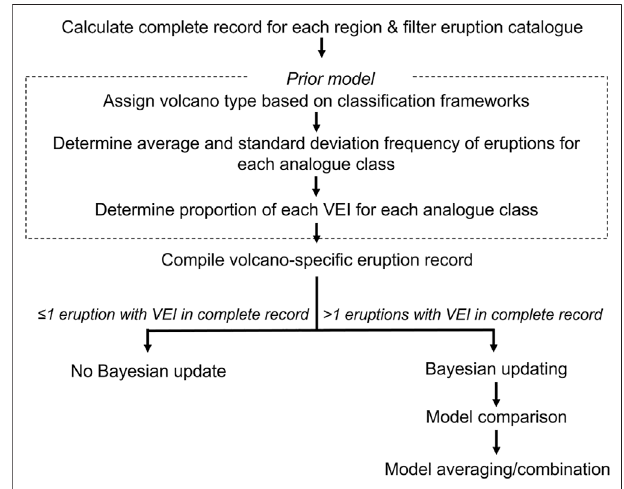
FIGURE 1 | Conceptual overview of the process taken in this paper to derive frequency-magnitude relationships in Southeast